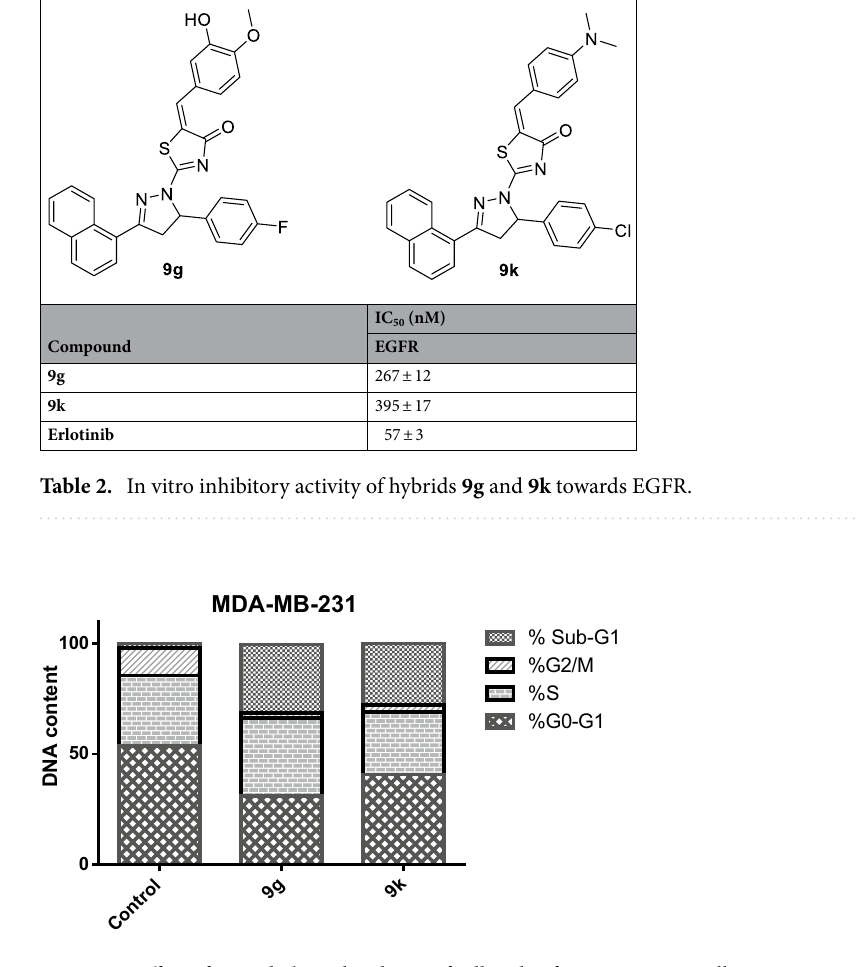
Figure 2. Effect of 9g and 9k on the phases of cell cycle of MDA-MB-231 cells.